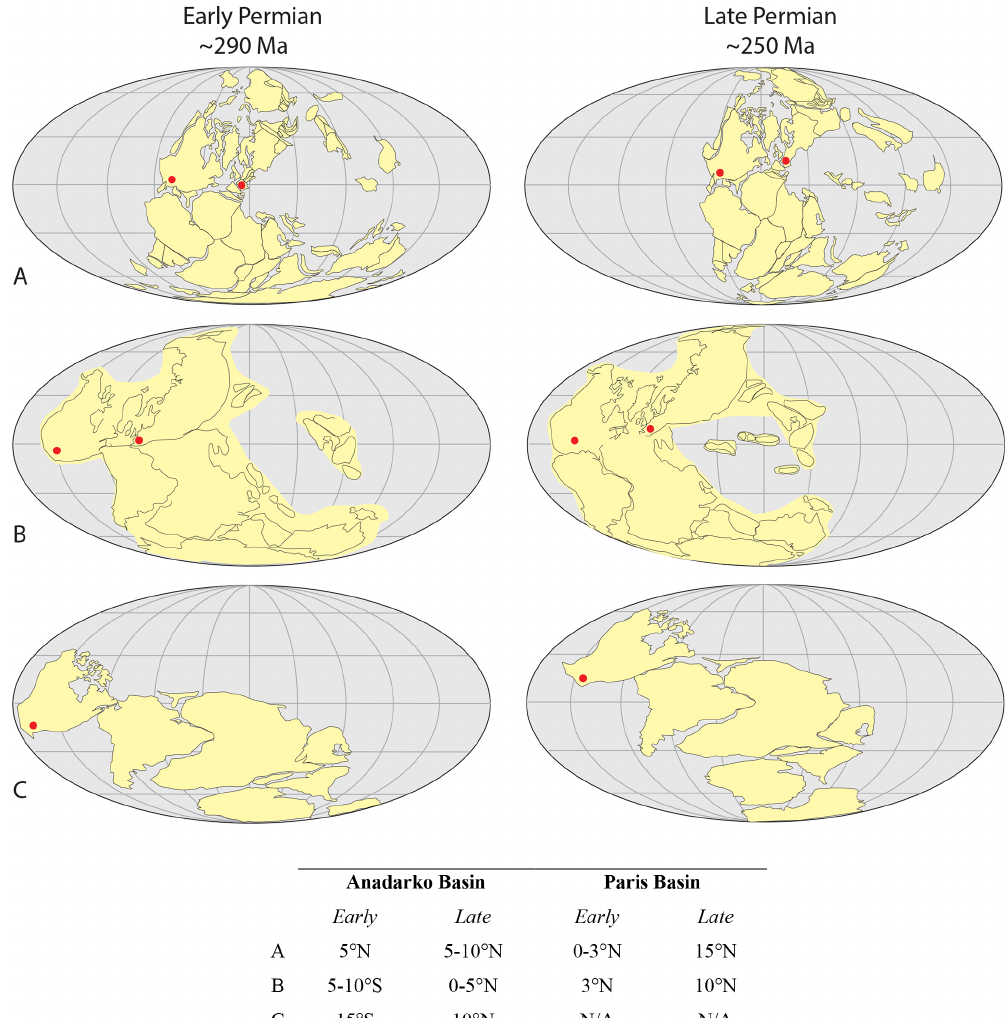
Figure 1. Paleogeography during the early to late Permian redrafted from the reconstructions of (a) Domeier and Torsvik (2014), (b) Muttoni and Kent (2019), and (c) Tomezzoli et al. (2018). Red dots show drill target paleo-positions within the equatorial Central Pangaean Mountains (western US – western equatorial Pangaea and western Europe – eastern equatorial Pangaea). A significant difference between (a) and (b) relates to the contrasting reconstructions of Pangaea A and Pangaea B. Pangaea A prevails for the later Permian, whereas some prefer Pangaea B for the early Permian. The reconstruction of Tomezzoli et al. (2018) focuses on Laurentia and Gondwana. In all cases, the target sites are generally equatorial but vary by up to ∼ 18 ◦ (coordinates for each configuration summarized in the table